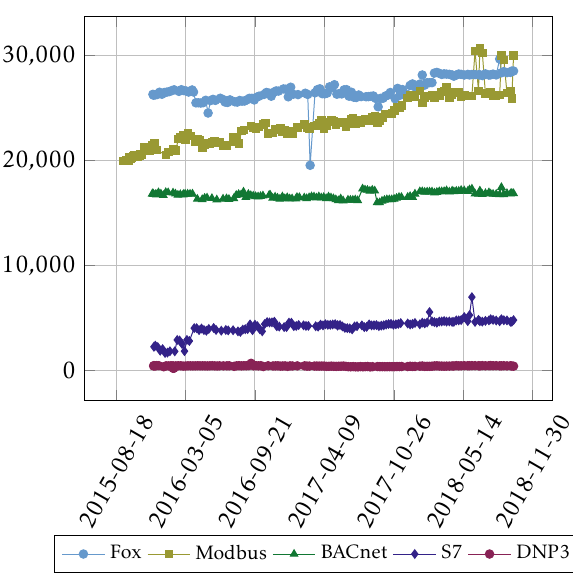
Figure 2. Available SCADA services reachable from the Internet starting from September 2015 up to the beginning of October 2018 based on data from the Censys database